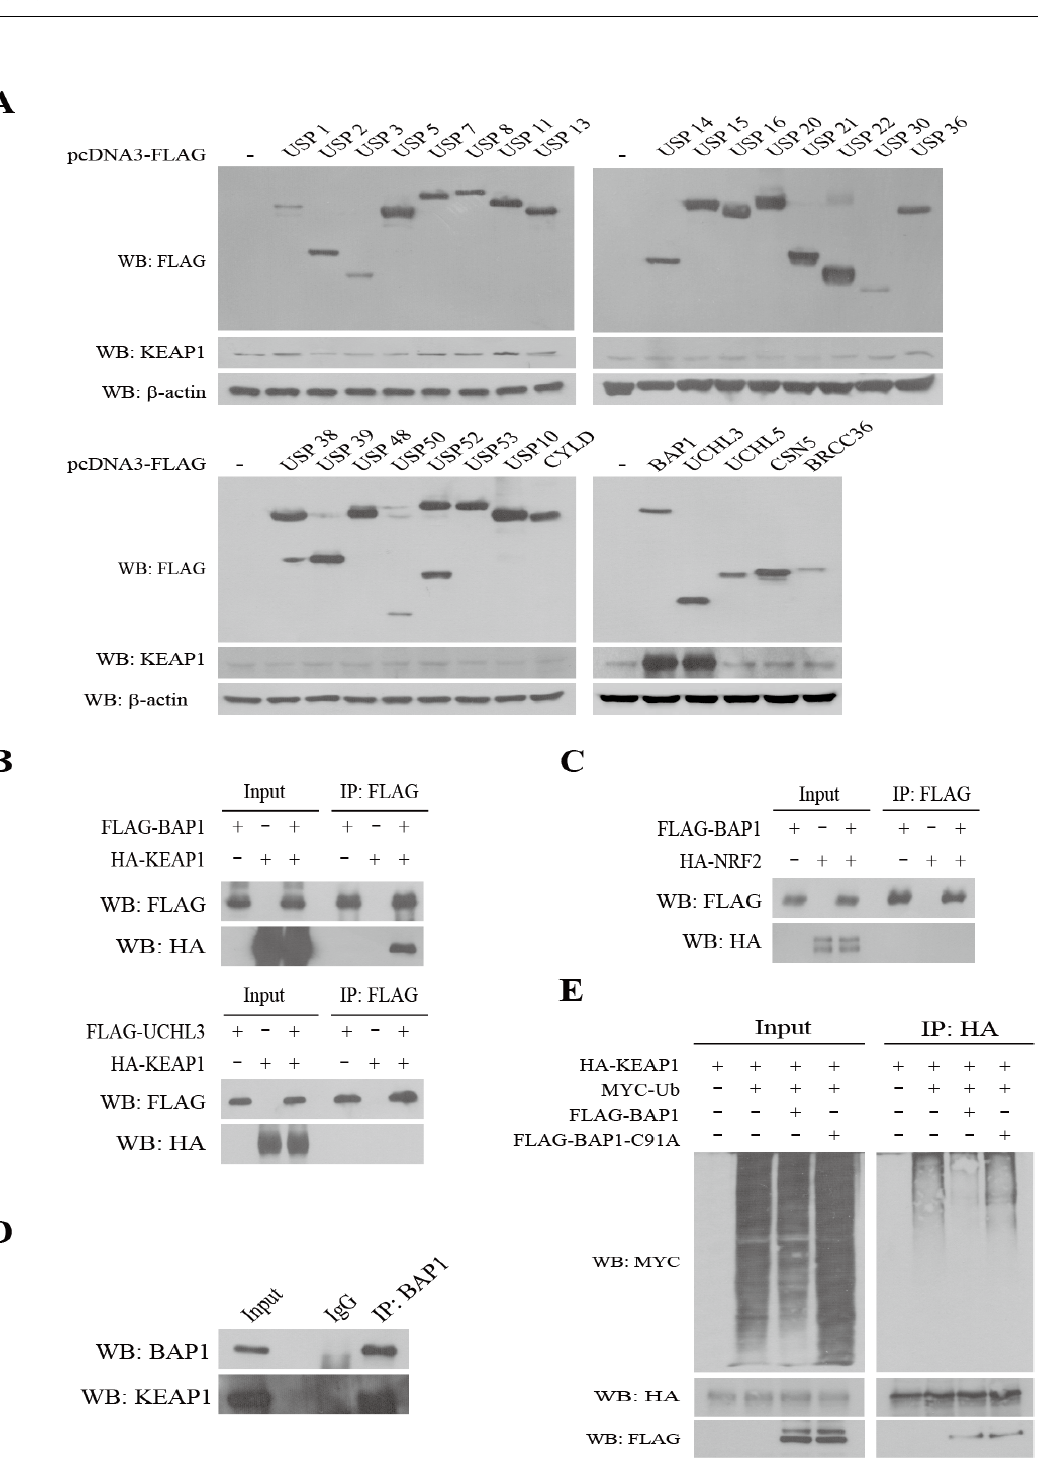
KEAP1 (Figure 1D). Overexpression of pcDNA3-FLAG-BAP1 attenuated polyubiquitina-